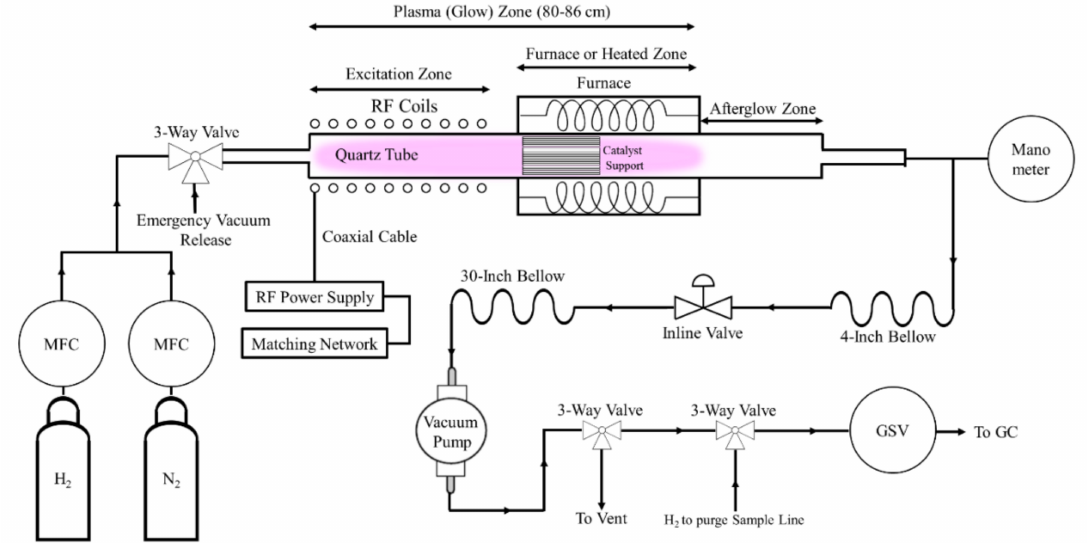
Figure 4. Schematic of the in-house built RF plasma reactor and surrounding equipment for gas inlet and outlet.